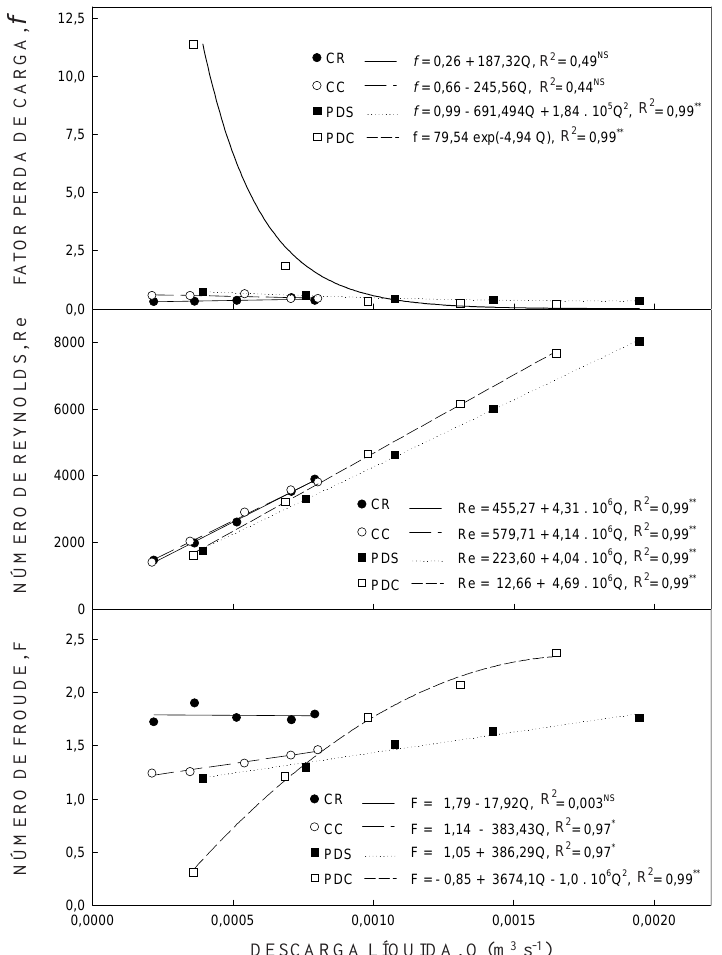
Figura 2. Fator perda de carga ( ƒƒƒƒƒ ), número de Reynolds (Re) e de Froude (F) e descarga líquida (Q), considerando diferentes preparos e consolidação do solo (CR = convencional recente, CC = convencional consolidado, PDS = plantio direto sem palha, PDC = plantio direto com palha). ** = significativo (P < 0,01); * = significativo (P < 0,05); NS =